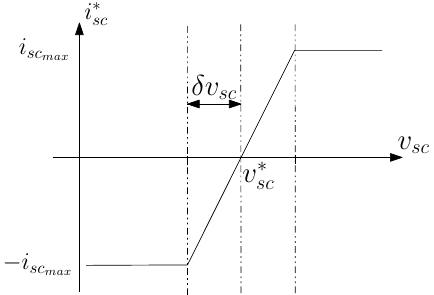
Figure 9. Definition of the SCs current according the SCs voltage for controller